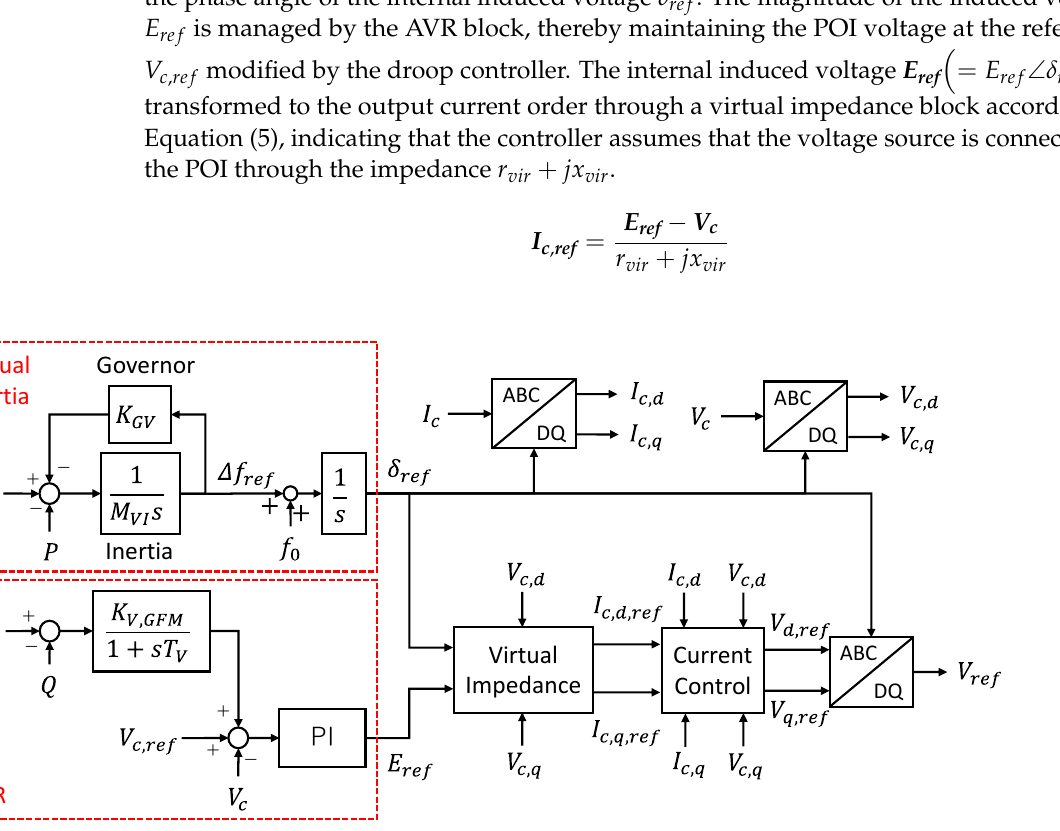
Table 1. Indices of the simulation study.